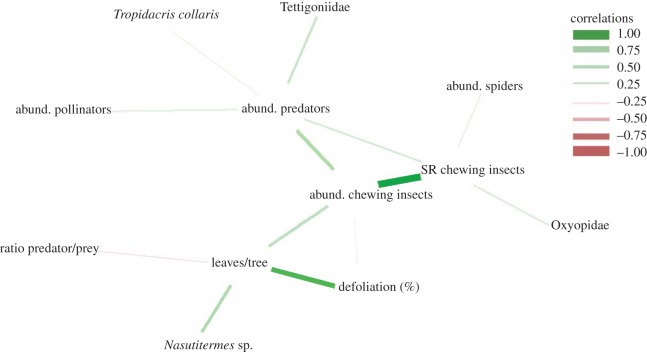
Estimated network structures based on Spearman correlation (p < 0.05) generated for abundance (abund.) of chewing, pollinator and predator insects, predator spiders, species richness (SR) of chewing insects, defoliation (%), ratio predator per prey, numbers of Nasutitermes sp. (Blattodea: Termitidae), Oxyopidae (Araneae), Tettigoniidae (Orthoptera) and Tropidacris collaris (Orthoptera: Romaleidae) on Acacia mangium (Fabales: Fabaceae) per tree n = 48.